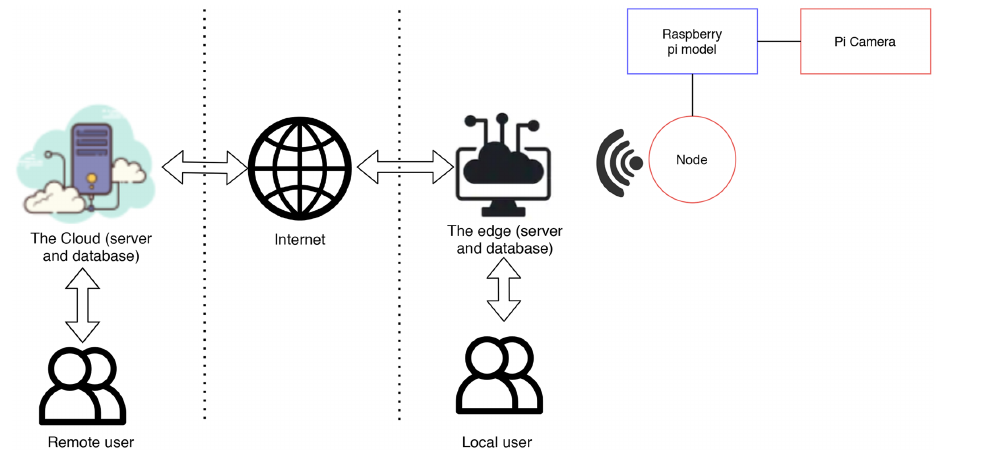
Figure 2. System architecture for the IoT-based optimum tea fermentation monitoring system.